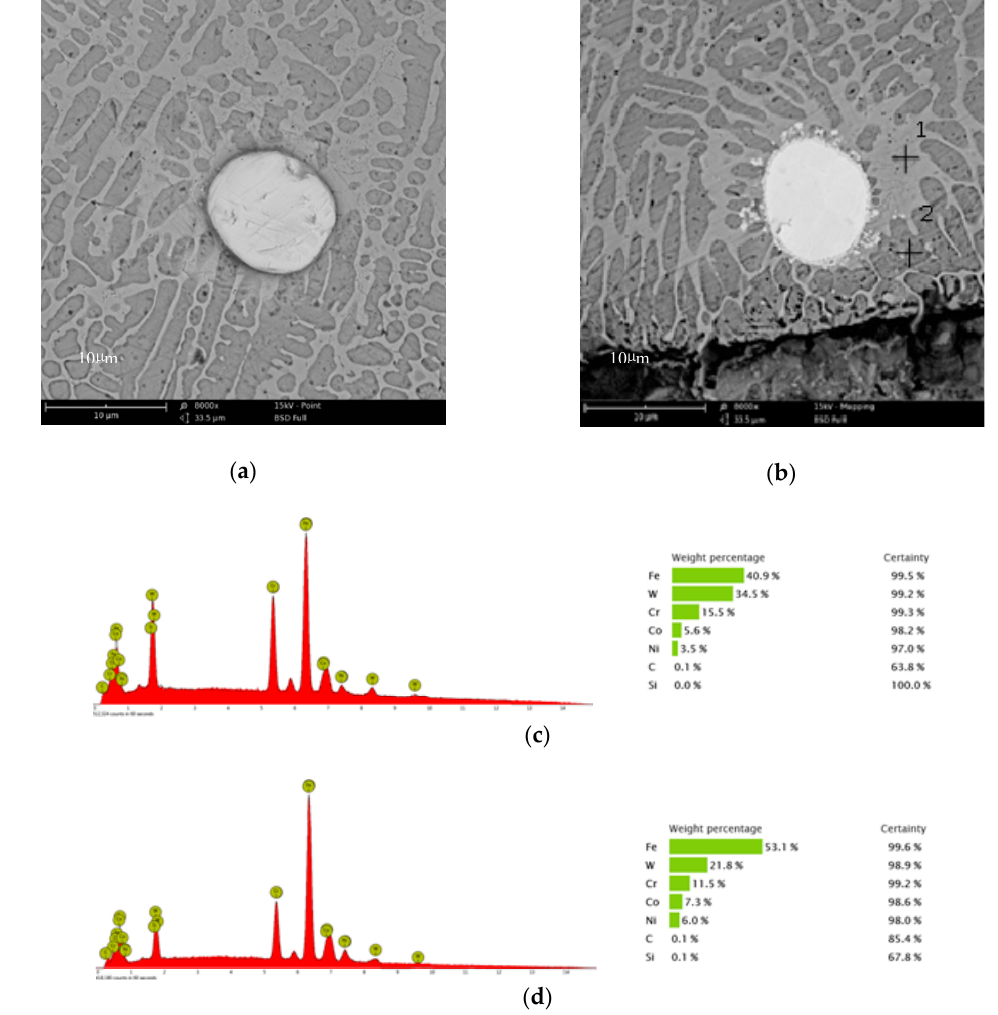
Figure 7. The influence of Co on the microstructures of coatings ( a ) without addition of Co, ( b ) with 8% Co addition. ( c ) EDS of point 1, ( d ) EDS of point 2.